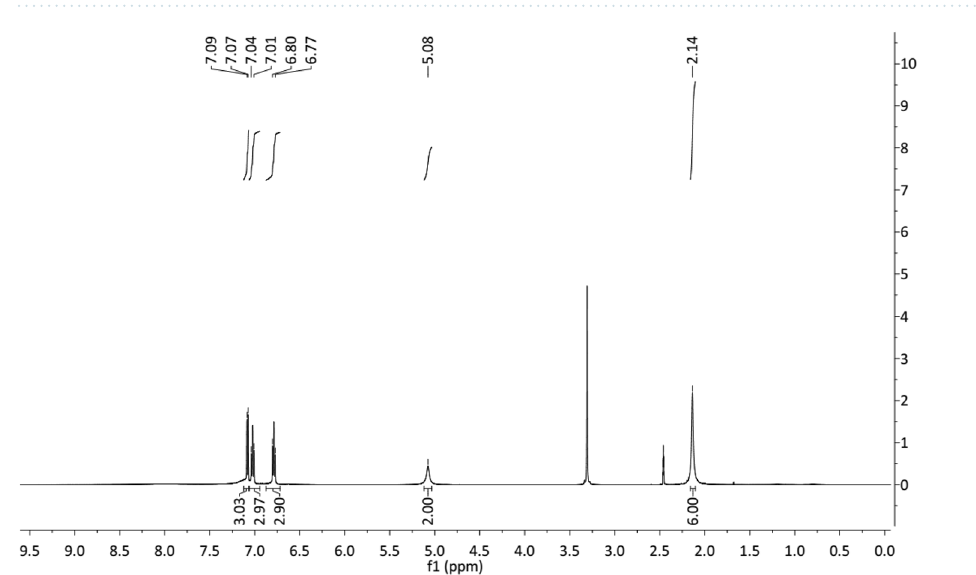
Figure 3. 1 HNMR spectrum of the DTG inhibitor in DMSO- d 6